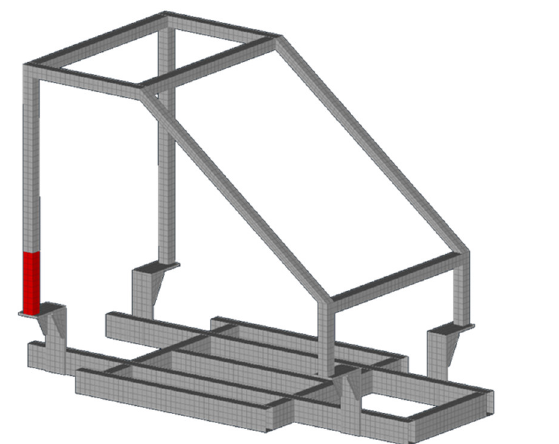
Figure 12. Damaged FE model of Case 2.